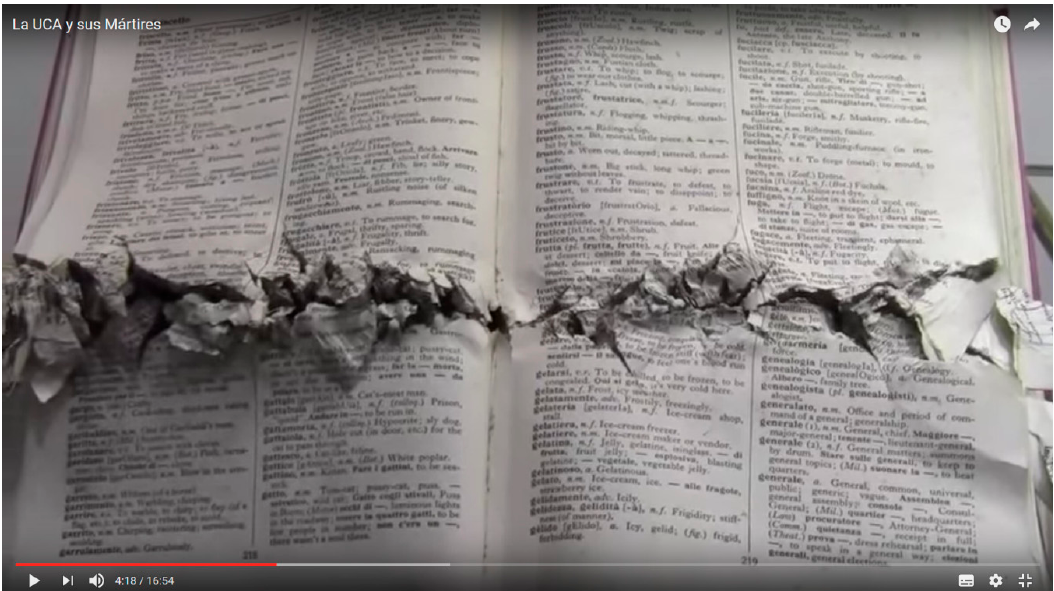
Figure 2. A book damaged during the attack to the Jesuits home. Said to be a Bible, is actually a dictionary. Screenshoot taken from Ochoa (2011).